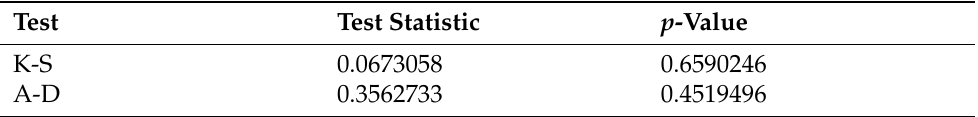
Table 8. Goodness-of-fit for Gauteng